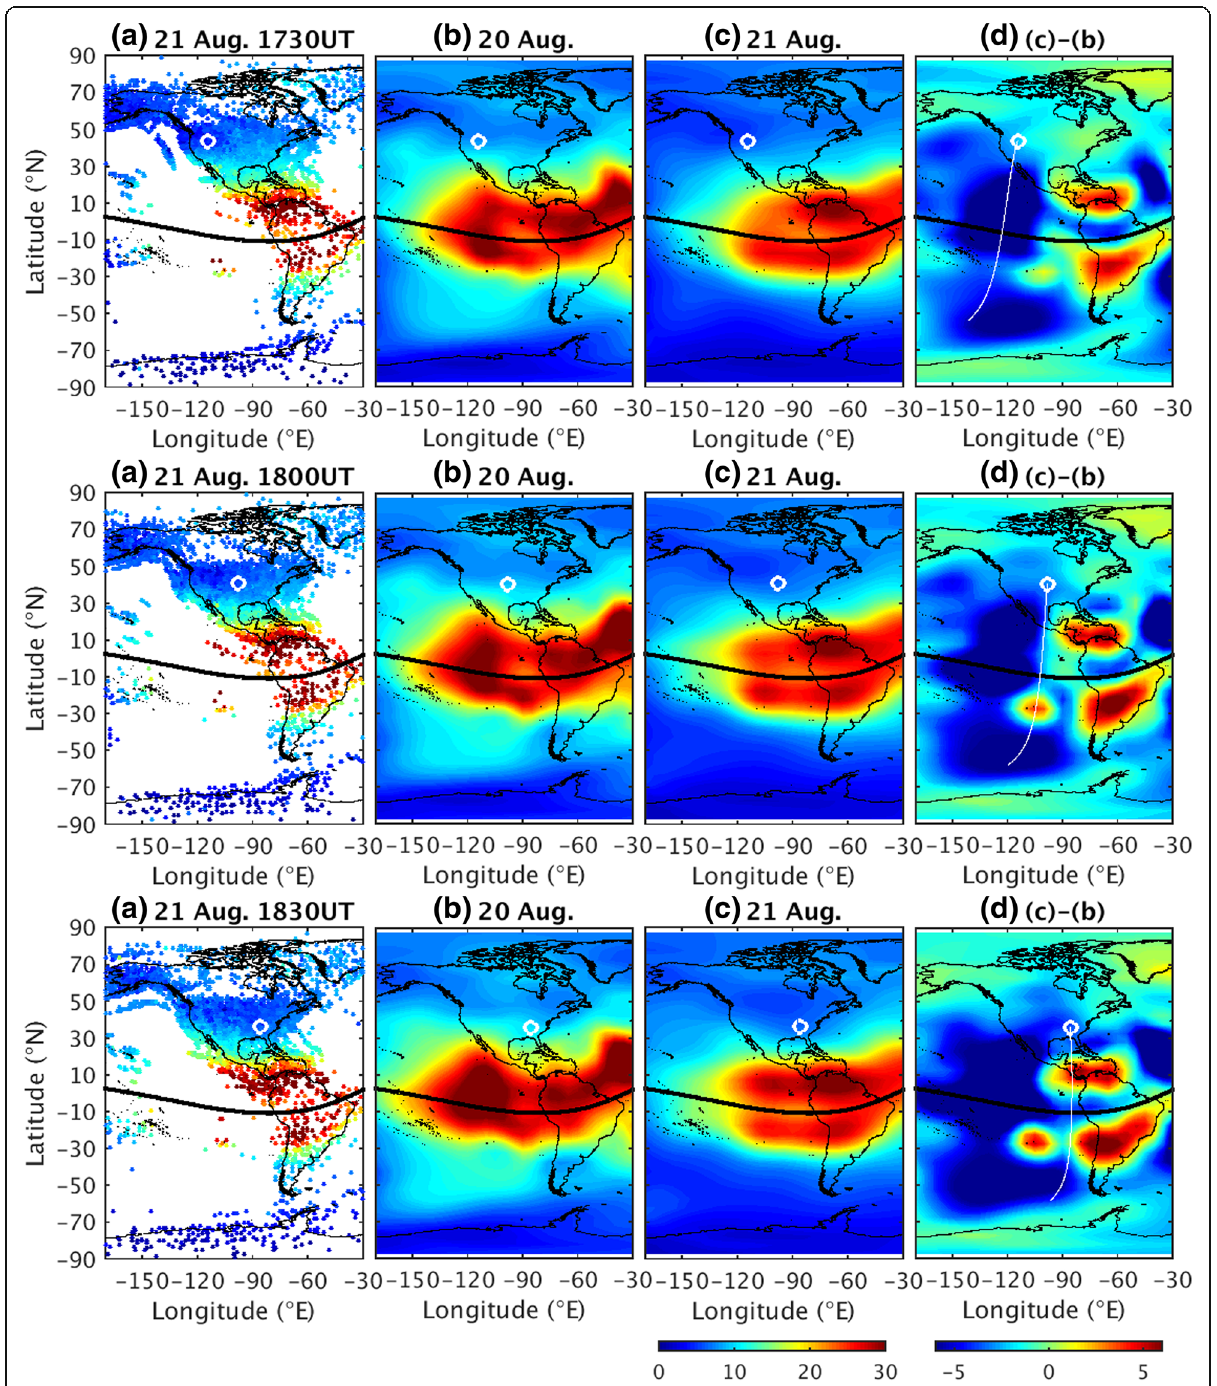
Fig. 1 Comparisons of GNSS TEC observations ( a ), data assimilation results on the eclipse previous day ( b ) and the eclipse day ( c ), and the TEC difference between these 2 days ( d ) around the North and South America regions at 1730 UT (top panels), 1800 UT (middle panels), and 1830 UT (bottom panels), respectively. Black indicates the magnetic equator. White circle is the location of maximum obscuration of the solar eclipse. The white line in d indicates the locations of geomagnetic field line projecting to the ground surface. The field line start from the location of the solar eclipse (white circle) to its conjugate location in the southern